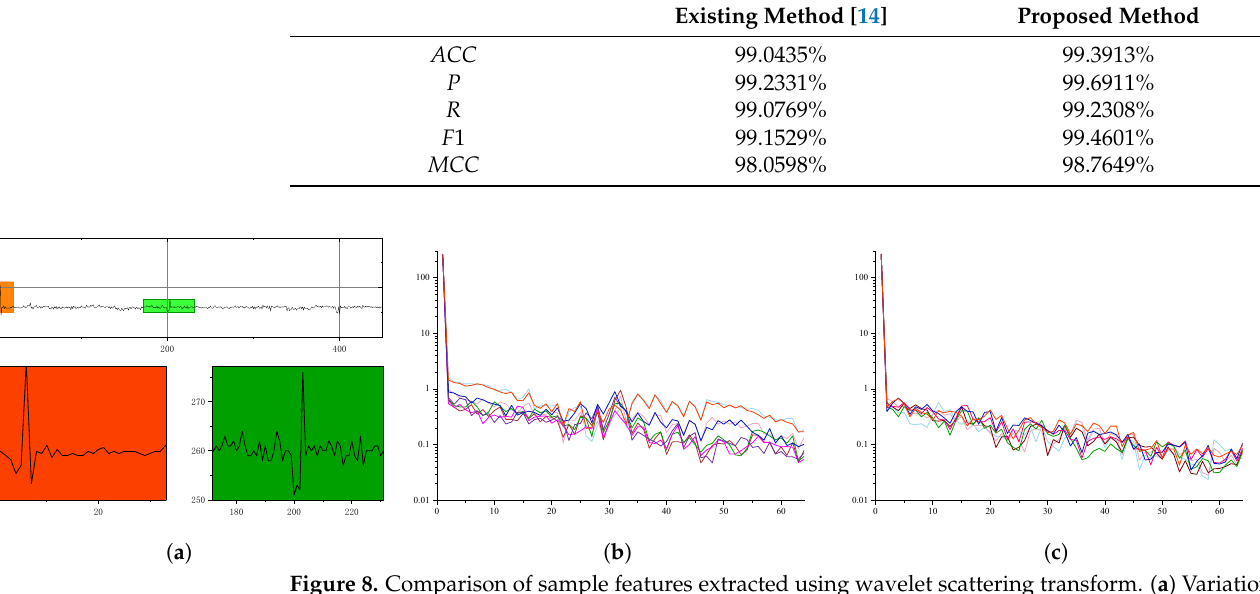
Figure 8. Comparison of sample features extracted using wavelet scattering transform. ( a ) Variation in detail of hard-to-capture microcrack sample signals. ( b ) Extraction of 8 time windows of feature information for such cracked eggs using WST, where eight different colors lines in the figure represent the information of the eight time windows. ( c ) Extraction of 8 time windows of feature information for intact eggs using WST, where eight different colors lines in the figure represent the information of the eight time